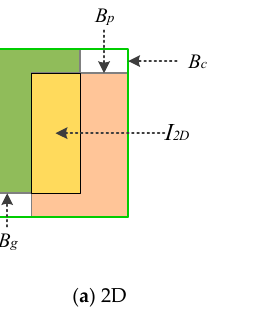
Algorithm 1: 3D Generalized Intersection Over Union Loss